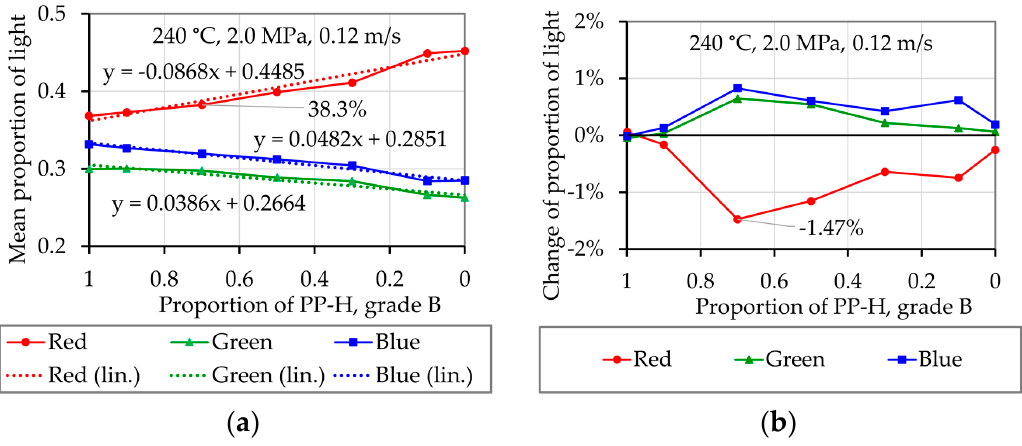
Figure 18 . Composition of the light in the melt film for the mixture PP-H/HDPE as a function of the proportion of PP-H, grade B: ( a ) Mean values, the dashed line shows the linearized functions; ( b ) the change of the composition of the light ∆ ξ RGB , S 3